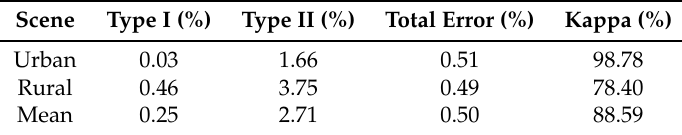
Table 1. Errors and kappa coefficients for the synthetic